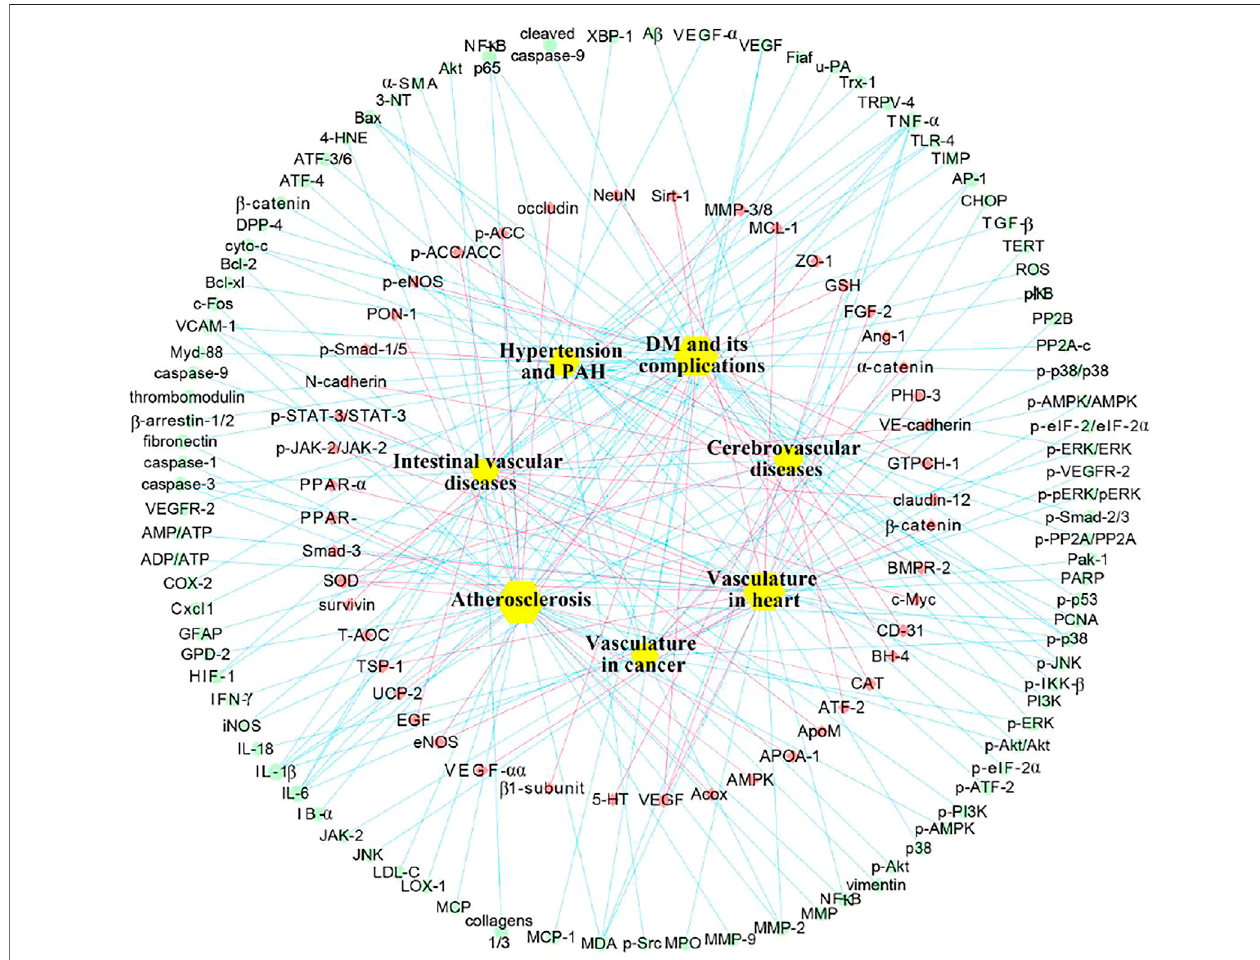
FIGURE5| Networkdiagram ofberberine involvedgeneand protein targetsintreatingvasculardiseases. Theyellowcubes intheinnermostcircle arethevascular disease treated with berberine, the red dots in the middle circle represent the up-regulated gene and protein targets, and the blue dots in the outside circle denote the down-regulated gene and proteins. Abbreviations: 3-NT, 3-nitrotyrosine; 4-HNE, 4-hydroxynoneal; 5-HT, 5-hydroxytryptamine; ADP, adenosine diphosphate; Akt, protein kinase B; AMP, adenosine monophosphate; AMPK, AMP-activated protein kinase; AP-1, activator protein 1; APOA-1, apolipoprotein A-1; ApoM, apoprotein M; ATF-4, activating transcription factor 4; ATP, adenosine triphosphate; Bax, Bcl-2 associated X protein; Bcl-2, B-cell lymphoma 2; BH-4, tetrahydrobiopterin; BMPR-2, bone morphogenetic protein type 2; CAT, catalase; CD-31, platelet endothelial cell adhesion molecule 1; CHOP, C/EBP homologous protein; CLP, cecal ligation and puncture; c-Myc, Myc proto-oncogene protein; COX-2, cyclo-oxygenase 2; CPT-1 α , carnitine palmitoyl transferase 1 α ; Cyto-c, cytochrome c; DM, diabetes mellitus; DPP-4, dipeptidyl peptidase 4; EGF, epithelial growth factor; eIF-2 α , eukaryotic initiation factor 2 α ; eNOS, endothelial nitric oxide synthase; ERK, extracellular signal-regulated kinase; FABP-4, fatty acid binding protein 4; FGF-2, fi broblast growth factor 2; GFAP, glial fi brillary acidic protein; GPD-2, glycerol-3-phospate dehydrogenase 2; GSH, glutathione; HIF-1 α , hypoxia-inducible factor 1 α ; IFN- γ , interferon γ ; IKK- β , IkappaB kinase β ; IL-6, interleukin 6; iNOS, inducible nitric oxide synthase; JNK, c-Jun N-terminal kinase; LDL-c, low density lipoprotein cholesterol; LOX-1, low-density lipoprotein receptor 1; MAO, monoamine oxidase;MCL-1,myeloidcellleukemia1;MCP,monocytechemoattractantprotein;MDA,malondialdehyde;MMP-2,matrixmetalloprotease 2;MPO,myeloperoxidase; Myd-88, myeloid differentiation factor 88; NF- κ B, nuclear factor κ B; PAH, pulmonary arterial hypertension; Pak-1, p21-activated kinase 1; PARP, poly (ADP-ribose) polymerase; PCNA, proliferating cell nuclear antigen; PHD-3, prolyl hydroxylase 3; PI3K, phosphoinositide 3-kinase; PON-1, paraoxonase 1; PP2Ac, protein phosphatase 2Ac; PP2B, calcineurin; PPAR- α , peroxisome proliferator-activated receptor α ; ROS, reactive oxygen species; SIRT-1, silent information regulator 1; Smad-3, small mother against decapentaplegic 3; SOD, superoxide dismutase; STAT-3, signal transducer and activator of transcription 3; T-AOC, total antioxidant capacity; TERT, telomerase reverse transcriptase; TGF- β , transforming growth factor β ; TIMP, tissue inhibitor of metalloproteinase; TLR-4, toll-like receptor 4; TNF- α , tumornecrosisfactor α ;TRPV-4,transientreceptorpotentialvanilloid4;Trx-1,Thioredoxin1;TSP-1,thrombospondin1;UCP-2,uncouplingprotein2;u-PA,urokinase- type plasminogen activator; VCAM-1, vascular cell adhesion molecule 1; VEGF- α , vascular endothelial growth factor α ; XBP-1, X-box binding protein 1; ZO-1, zona occluden 1; α -SMA, α -smooth muscle actin.